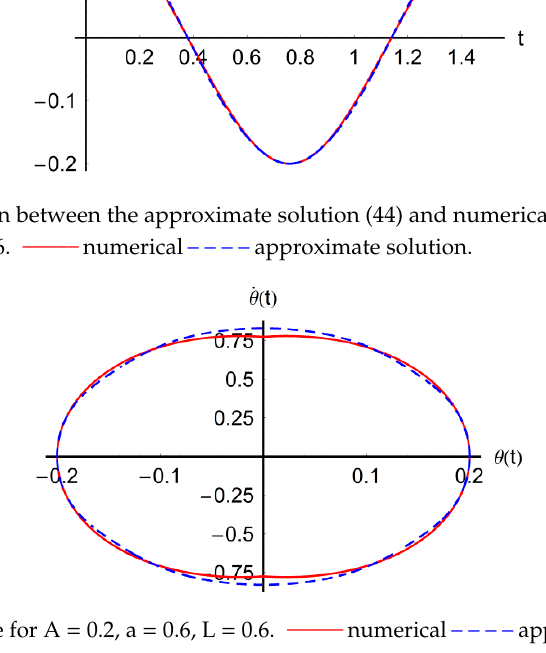
Figure 21. Phase plane for A = 0.4, L = 0.6. Figure 13. Phase plane for A = 0.2, a = 0.6, L = 0.6. _____ numerical_ _ _ _approximate solution (44). Figure 13. Phase plane for A = 0.2, a = 0.6, L = 0.6. Numerical approximate solution (50). _ _ _ _ approximate solution (50). Figure 20. Comparison between the approximate solution (50) and numerical integration results for